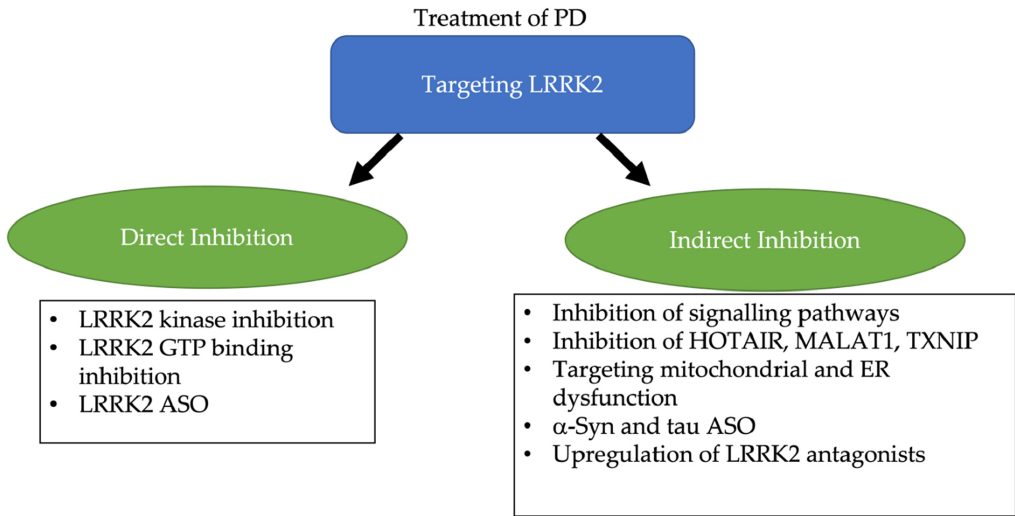
Figure 4. Summary of LRRK2 targeting strategies including direct inhibition, reducing LRRK2 activity and total protein levels, and indirect inhibition, inhibiting of downstream signalling pathways, inhibition of upregulation of LRRK2, targeting downstream effects, and upregulation of antagonists.